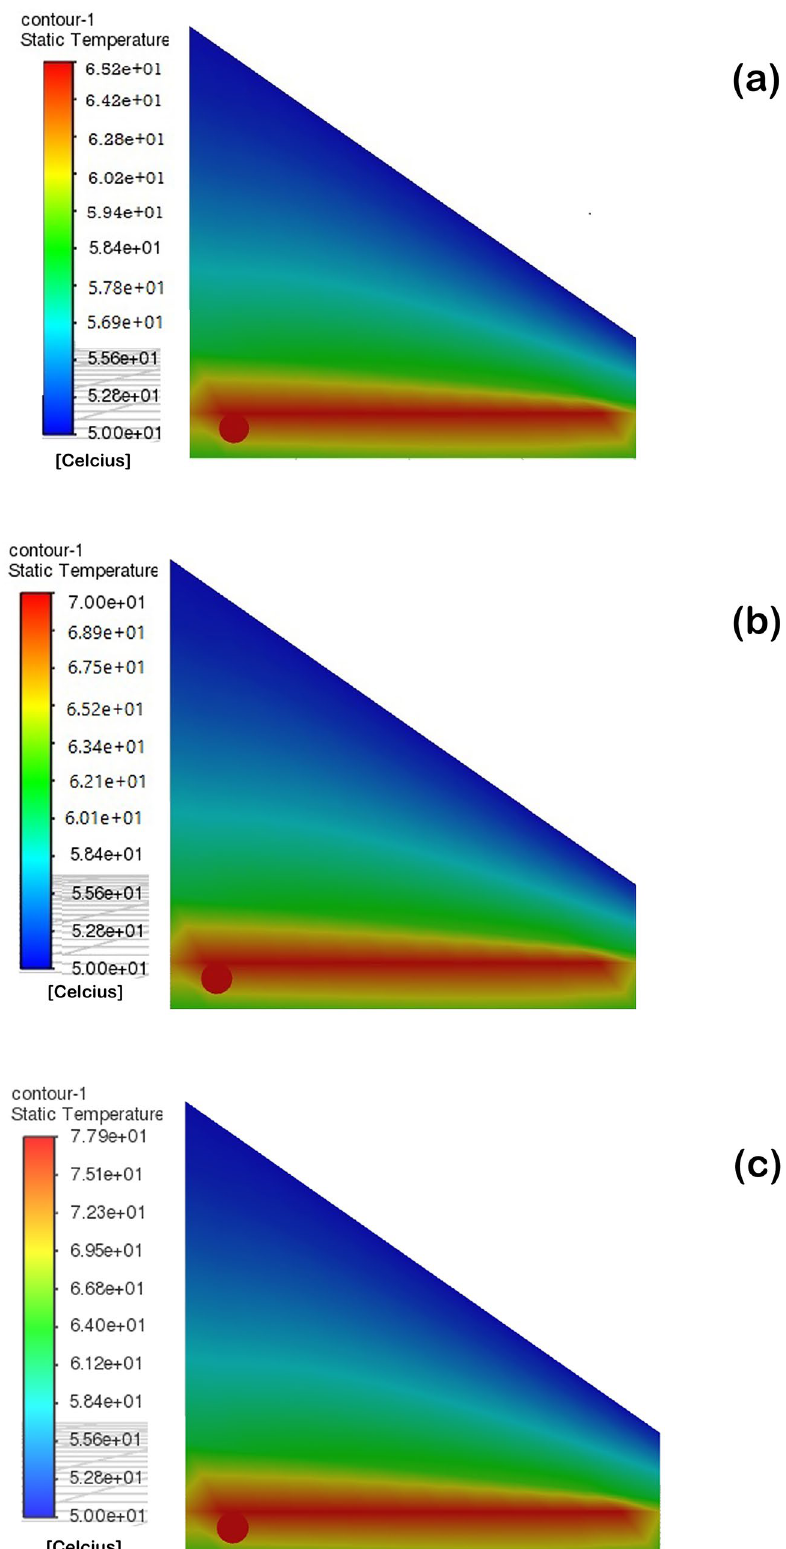
Figure 1. Simulation result of BTPSD with input temperature 50 °C (i) BTPSD without TIM (ii BTPSD 2 cm TIM thickness (iii) BTPSD with 4 cm TIM